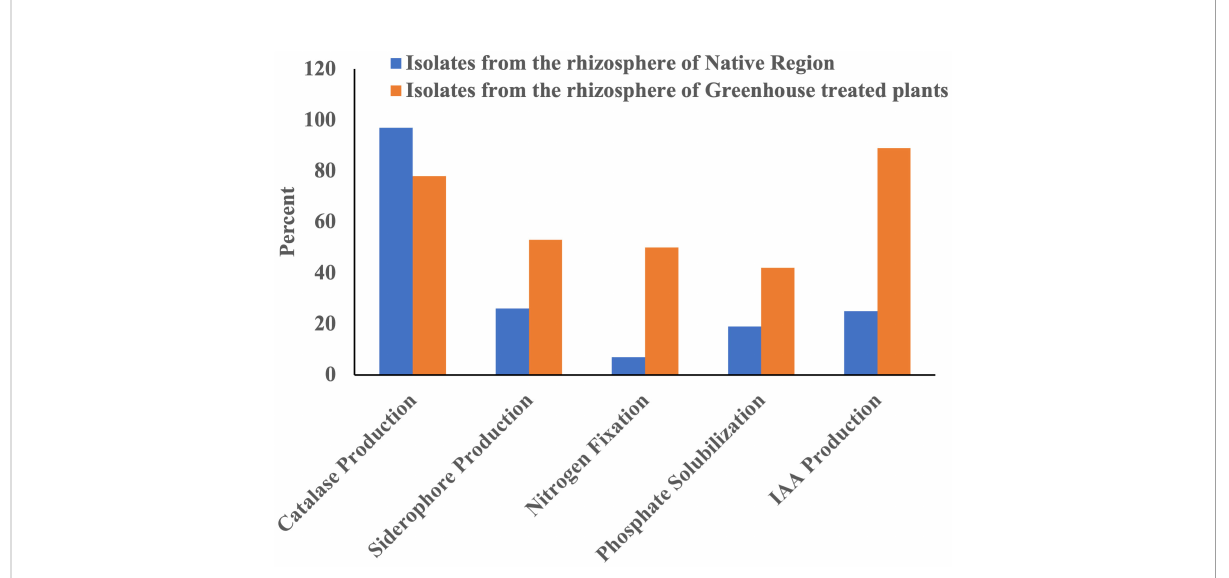
FIGURE 3 The abundance of isolates for plant growth-promoting traits in the rhizosphere of snowbrush ceanothus from native region and the rhizosphere of greenhouse treated snowbrush ceanothus